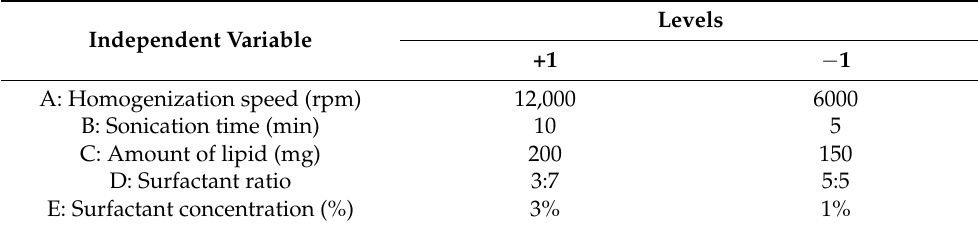
Table 1. Coded and actual values of independent variables for fractional factorial design. Independent Variable